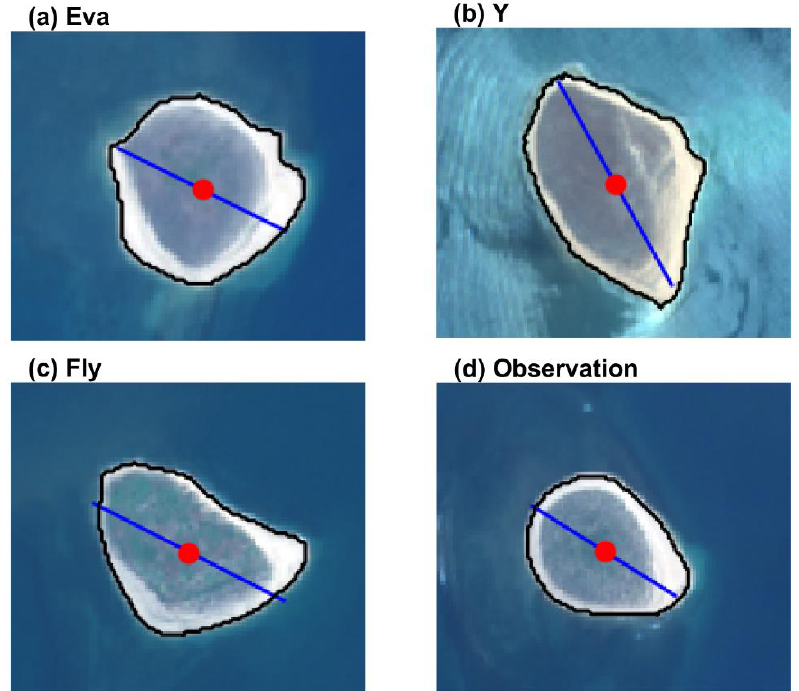
Figure 3. Example CoastSat.islands detection showing the detected shoreline (black line), centroid of the sandy area (red dot), and the major axis orientation (blue line) at the ( a ) Eva, ( b ) Y, ( c ) Fly, and ( d ) Observation islands.